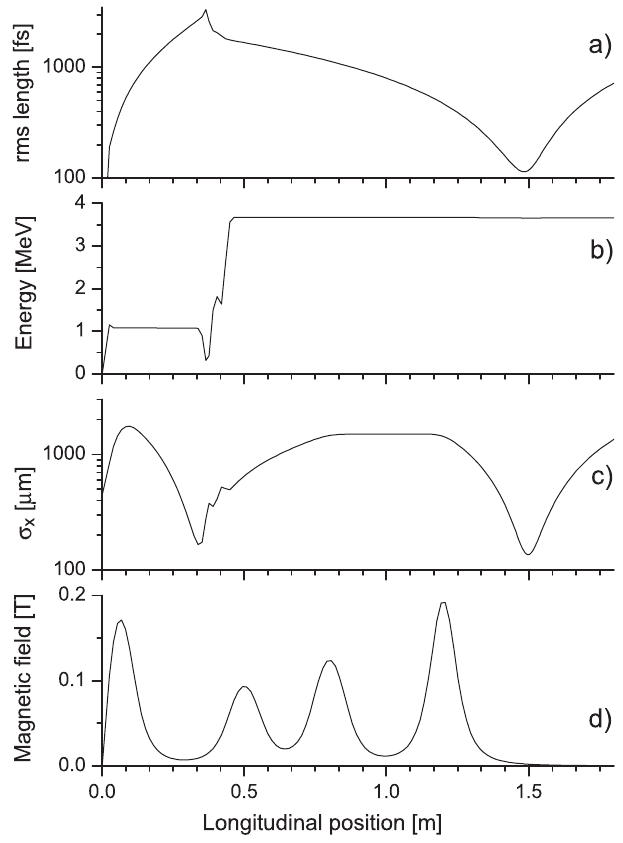
FIG. 2. GPT simulation results of (a) rms bunch length, (b) energy, and (c) rms transverse bunch size (cid:5) of position z ; (d) on-axis magnetic